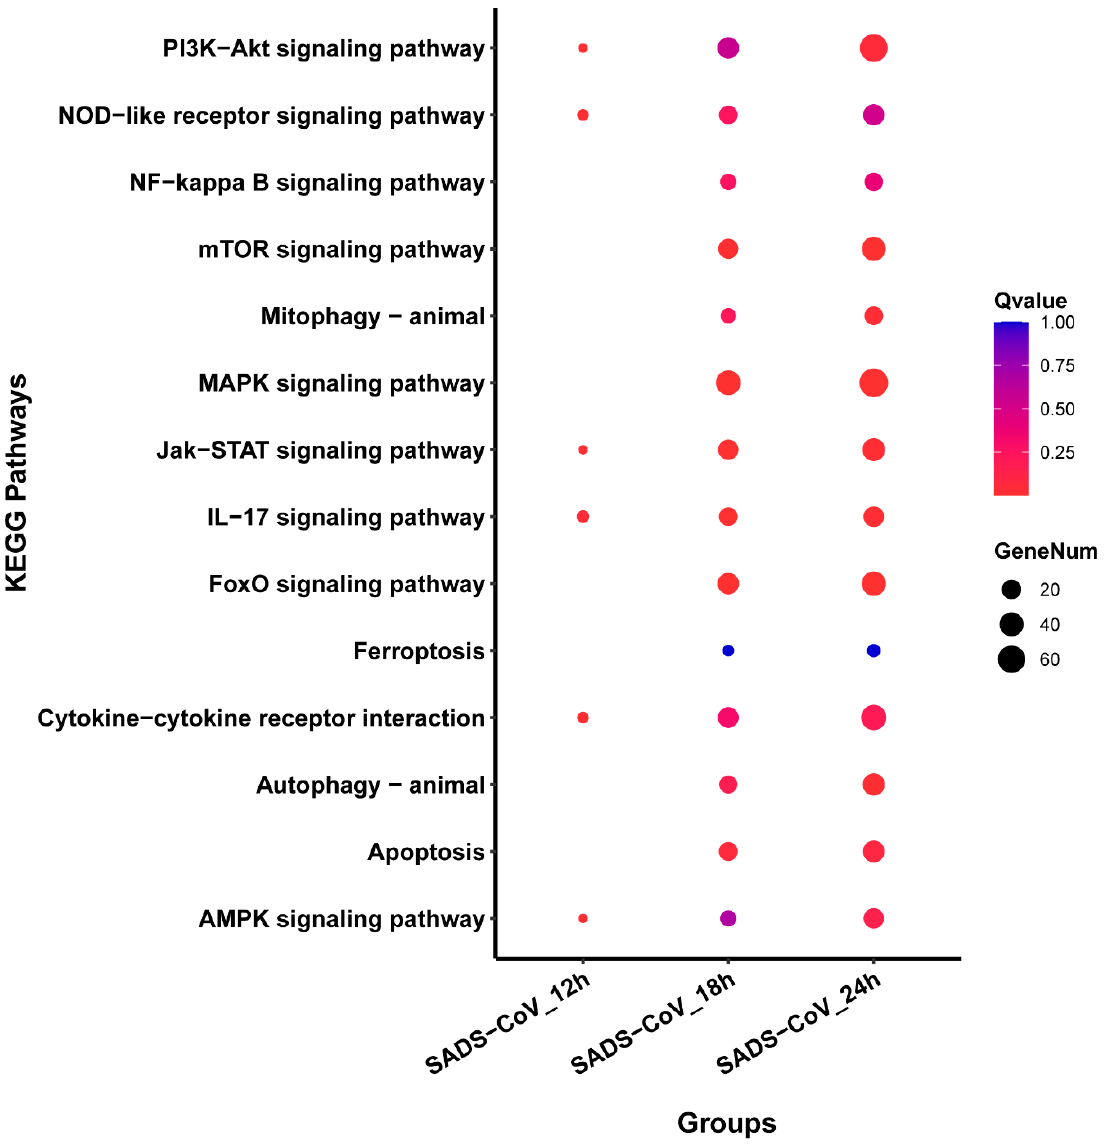
Figure 5. Dot map showing the compilation of top 14 enriched Kyoto encyclopedia of genes and genomes (KEGG) pathways in all SADS-CoV infection groups. Each vertical column of the dot represents a SADS-CoV infection group.